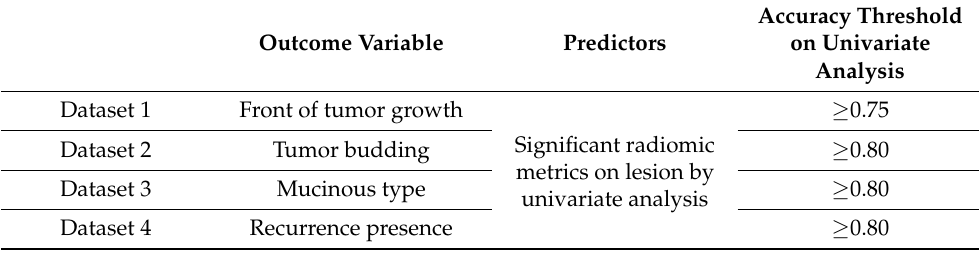
Table 2. (Sub) datasets, variable selection criteria, and predictor